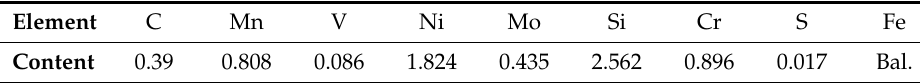
Table 1. Chemical compositions of the as-received 300M steel (weight %). Element